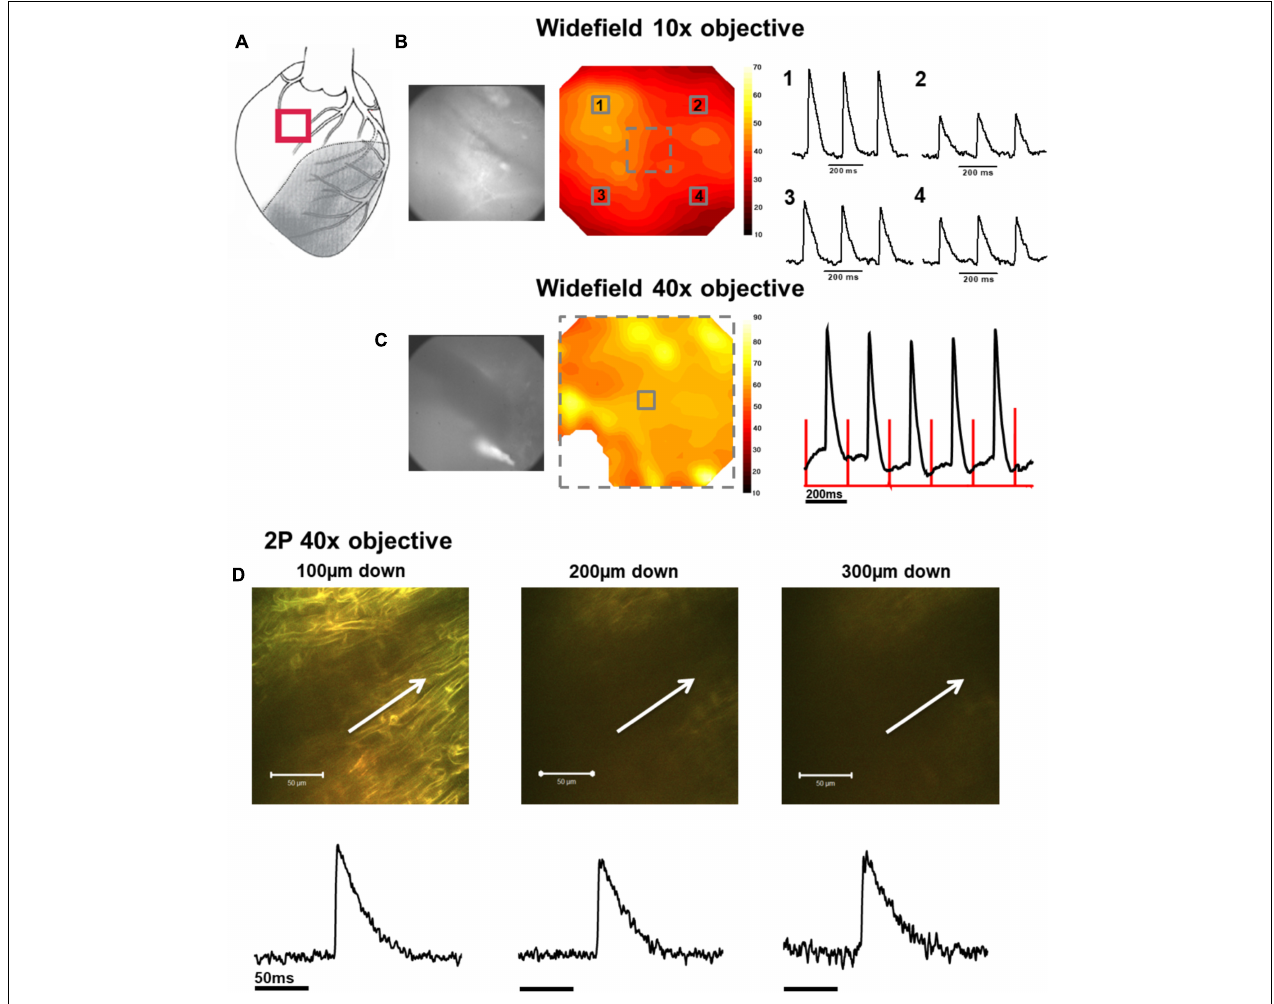
FIGURE 2 | Widefield and 2P signals in the normal zone (NZ). (A) Schematic diagram of the infarcted heart. The red square indicates the approximate location of the measurements in the NZ. (B) Widefield measurements were first taken from NZ using a 10 × objective. CMOS camera image (left) and signal-to-noise ratio contour map (middle) of di-4-ANEPPS fluorescence in the NZ. Line traces on the right show action potentials (APs) from 3 × 3 pixel averaged regions (indicated by numbered solid squares on contour map). (C) Measurements were focused to a smaller area using a 40 × objective [indicated by the dashed square on contour map in (B) ]. A CMOS camera (left) image and signal-to-noise ratio contour map (middle) taken from the NZ at 40 × magnification. An area in the bottom left of the contour map field was removed due to movement artifact distorting the signal. Right panel: 3 × 3 pixel average of the AP signal in the center of the optical field (defined by the solid square in the contour map). The red lines indicate the timing of the stimulus pulse. (D) A series of 2P measurements were made through increasing depth in the same optical field with the 40 × objective. Shown here are 2P images and corresponding averaged APs taken (from left to right) 100, 200, and 300 µ m below the tissue surface. White arrows in images indicate approximate length and direction of line scans. All the APs shown are an average of 25 APs recorded over a period of ∼ 5